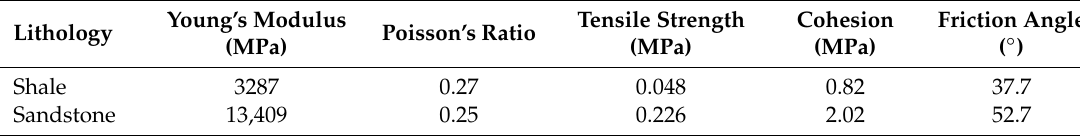
Table 2. Rock mass properties considered in the